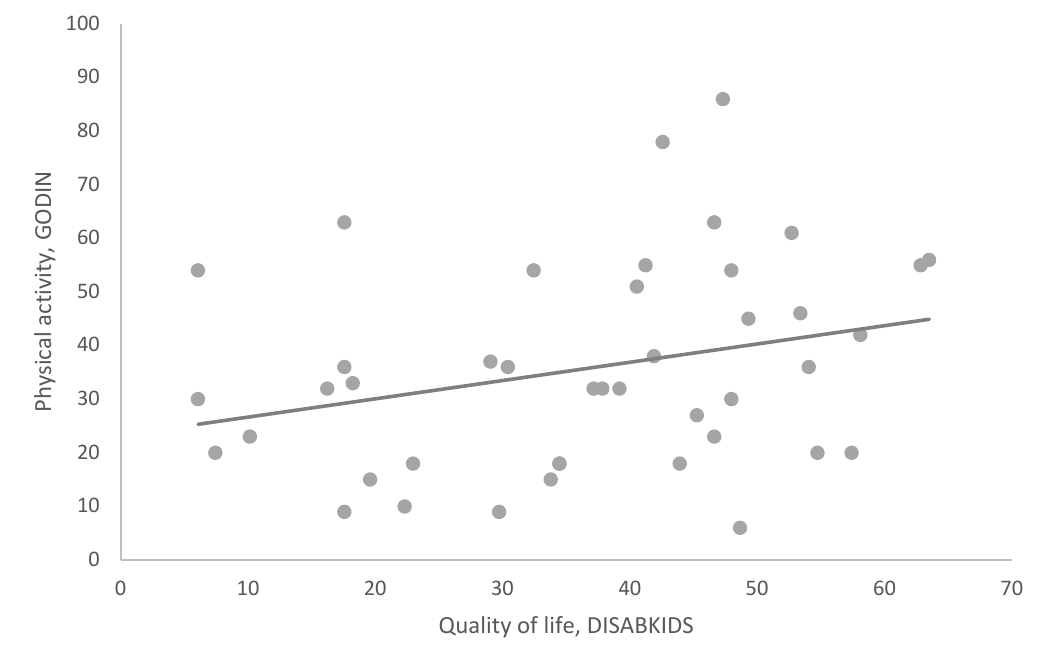
Figure 4. Patients with a greater degree of physical activity showed a better overall quality of life (r: 0.372; p : 0.014).